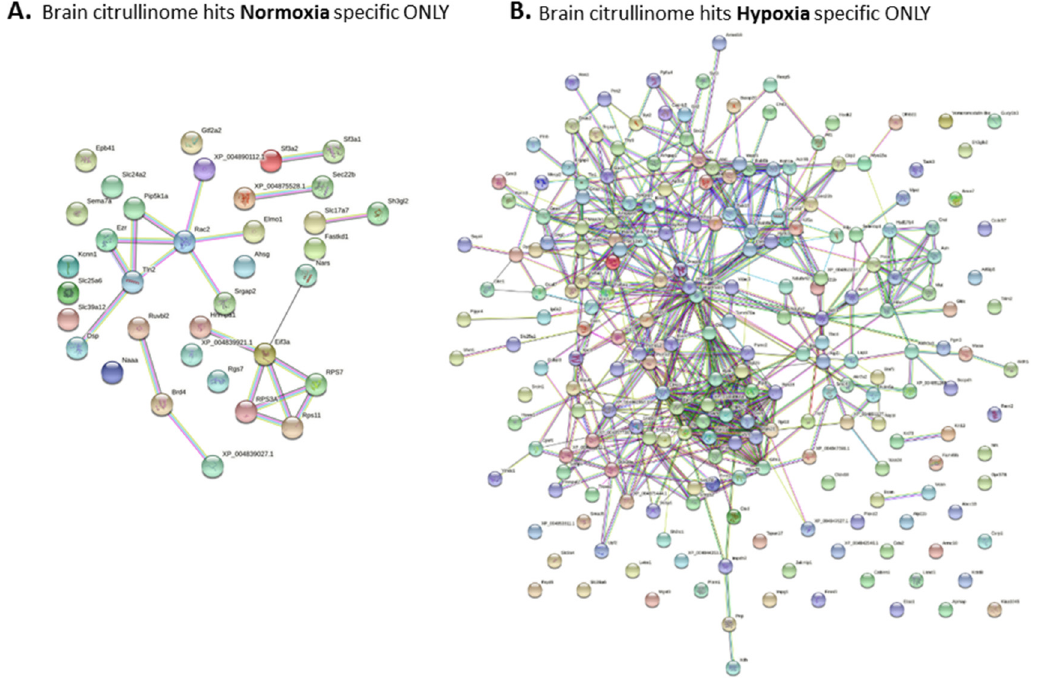
Figure 8. Protein networks built based on F95-enriched proteins identified in either the normoxia or hypoxia brains only. ( A ) F95 hits from normoxia brains only (not overlapping with the hypoxia group); ( B ) F95-enriched proteins identified in hypoxia brains only (not overlapping with the normoxia group). Table 7. KEGG pathways for F95 hits only identified in hypoxia brains (and not overlapping with the normoxia group). The 50 KEGG pathways are listed below that relate to the protein network built based on F95 hits in hypoxia brain only (shown in Figure 8B); the observed gene count for each pathway is listed; (*) are unique to this list only.